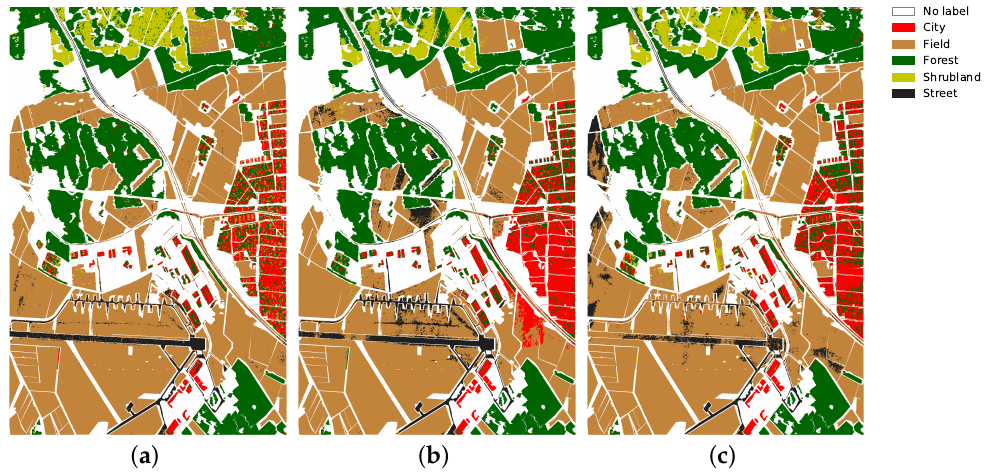
Figure 5. Classification results for raw data. ( a ) PolSAR CM raw data, BA = 77.4%; ( b ) TomoSAR CM raw data, BA = 73.3%; ( c ) Tomogram raw data, BA =